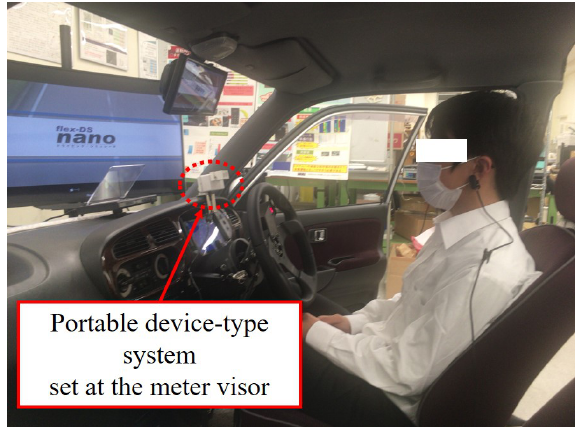
Figure 6. Portable device-type system set at the meter